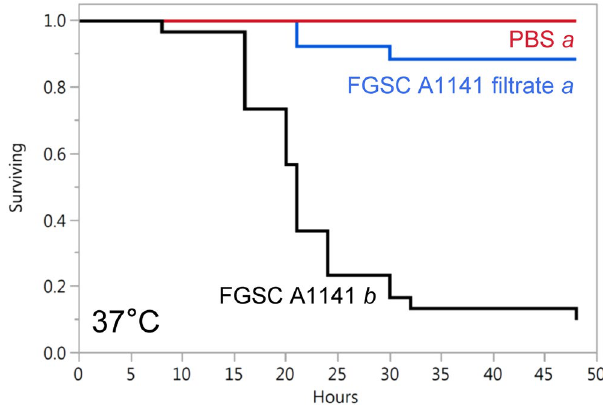
Figure 3. Survival curves for G. mellonella larvae injected with conidial suspensions of N. fumigata FGSC A1141, conidium-free, filtered suspensions of FGSC A1141, or phosphate-buffered saline control (PBS). Curves were derived from data from three trials with 10 larvae per treatment per trial. Treatment labels followed by different italicised letters have survival curves that differ significantly in a log-rank test with Bonferroni- adjusted alpha value set at 0.016 (derived from 0.05/three pairwise comparisons).